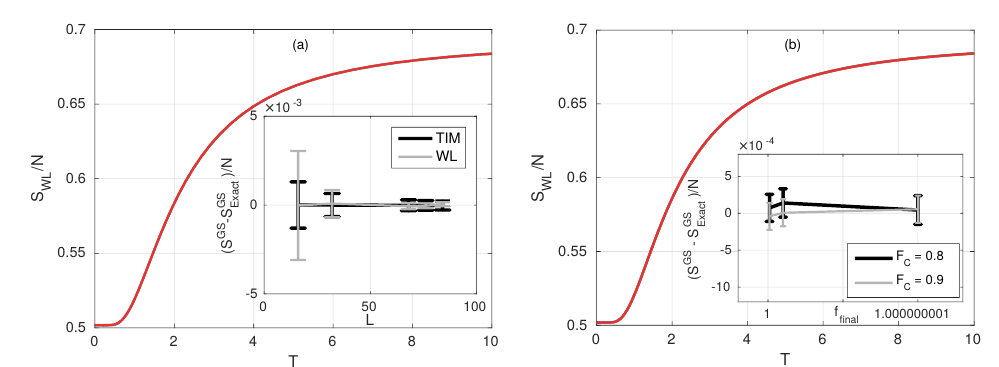
Figure 2. (a) Entropy density obtained by the WL method, for L = 16, 32, 68, 76, 84 with F C = 0 . 8 and f final = 1 + 10 − 8 . The lines for di ff erent L coincide and the errorbars (not shown) are smaller than the line widths. The inset shows di ff erences of the residual values by the respective methods from the exact value. (b) Entropy density curves for all combination of values of the WL parameters F C = 0 . 8, 0 . 9 and f final = 1 + 10 − 8 , 1 + 10 − 9 , 1 + 10 − 10 (the lines are almost identical) and their di ff erence from the exact value in the ground state